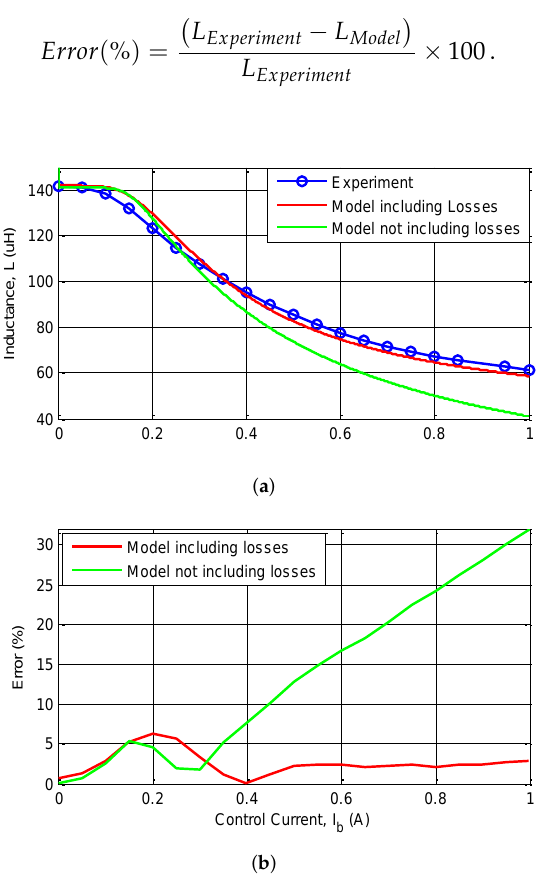
Figure 15. Small-signal characterization of the variable inductor prototype comparing simulation models with experimental results. ( a ) Inductance value, and ( b ) percentage error as a function of control